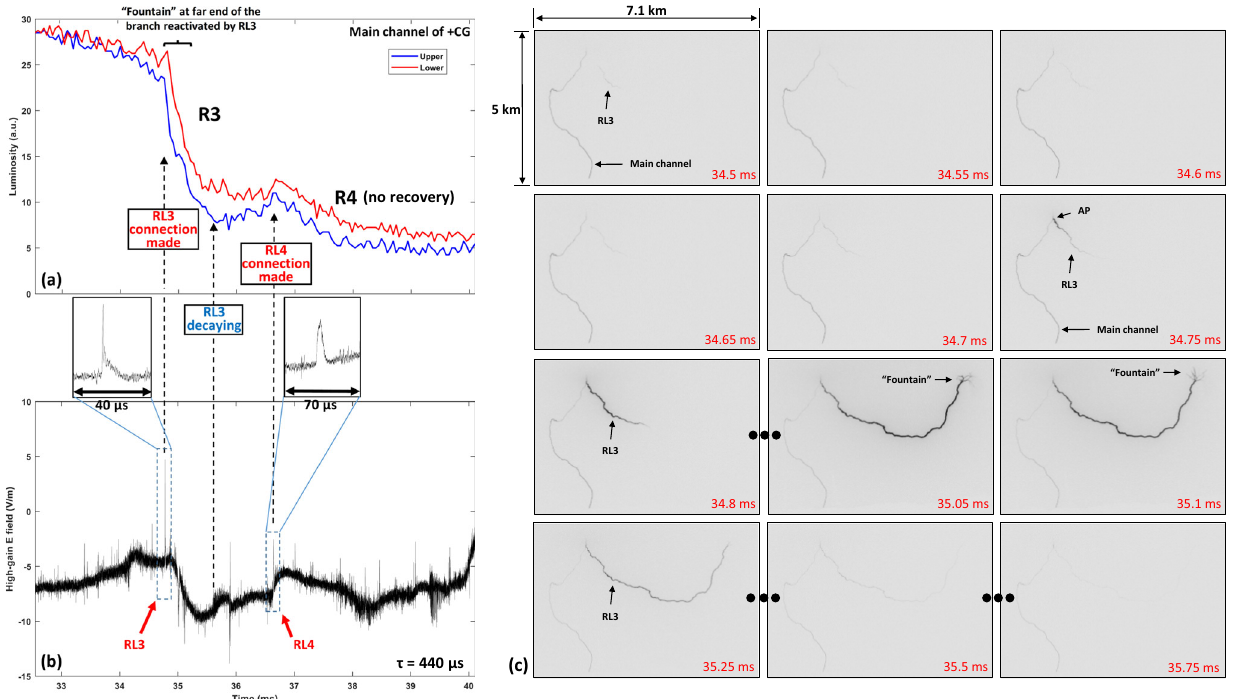
Fig. 5 Single-stroke positive Flash 1906. a and b “ Region 3 ” of Fig. 3a, c shown on an expanded time scale. Microsecond-scale E- fi eld pulses associated with collisions of RL3 and RL4 with the main channel are marked in b and shown expanded in two panels between a and b . R3 and R4 in a are luminosity dips with their onset times corresponding to the microsecond-scale pulses marked in b . c Selected Individual frames showing the evolution of RL3. Bidirectional extension of RL3 is seen in Frames 34.5 ms to 34.7 ms. Connection to the main channel is established in Frame 34.75 ms (AP stands for attachment point), and starting with Frame 35.5 ms the branch reactivated by RL3 gradually decayed. Luminosity of the main channel decreased (see the leading edge of luminosity dip R3 in a ) as a result of connection of RL3 to the main channel and partially recovered after the branch reactivated by RL3 started to decay. No recovery is seen in a for RL4 due to signi fi cant overall luminosity